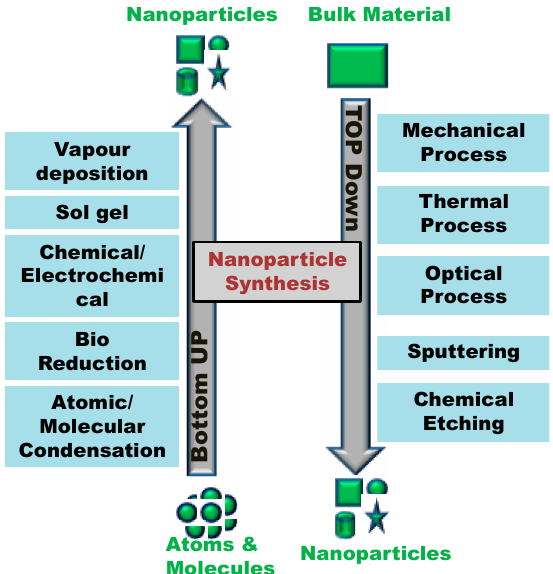
Figure 2. The concept of top down and bottom up technology: different methods for nanoparticle synthesis.